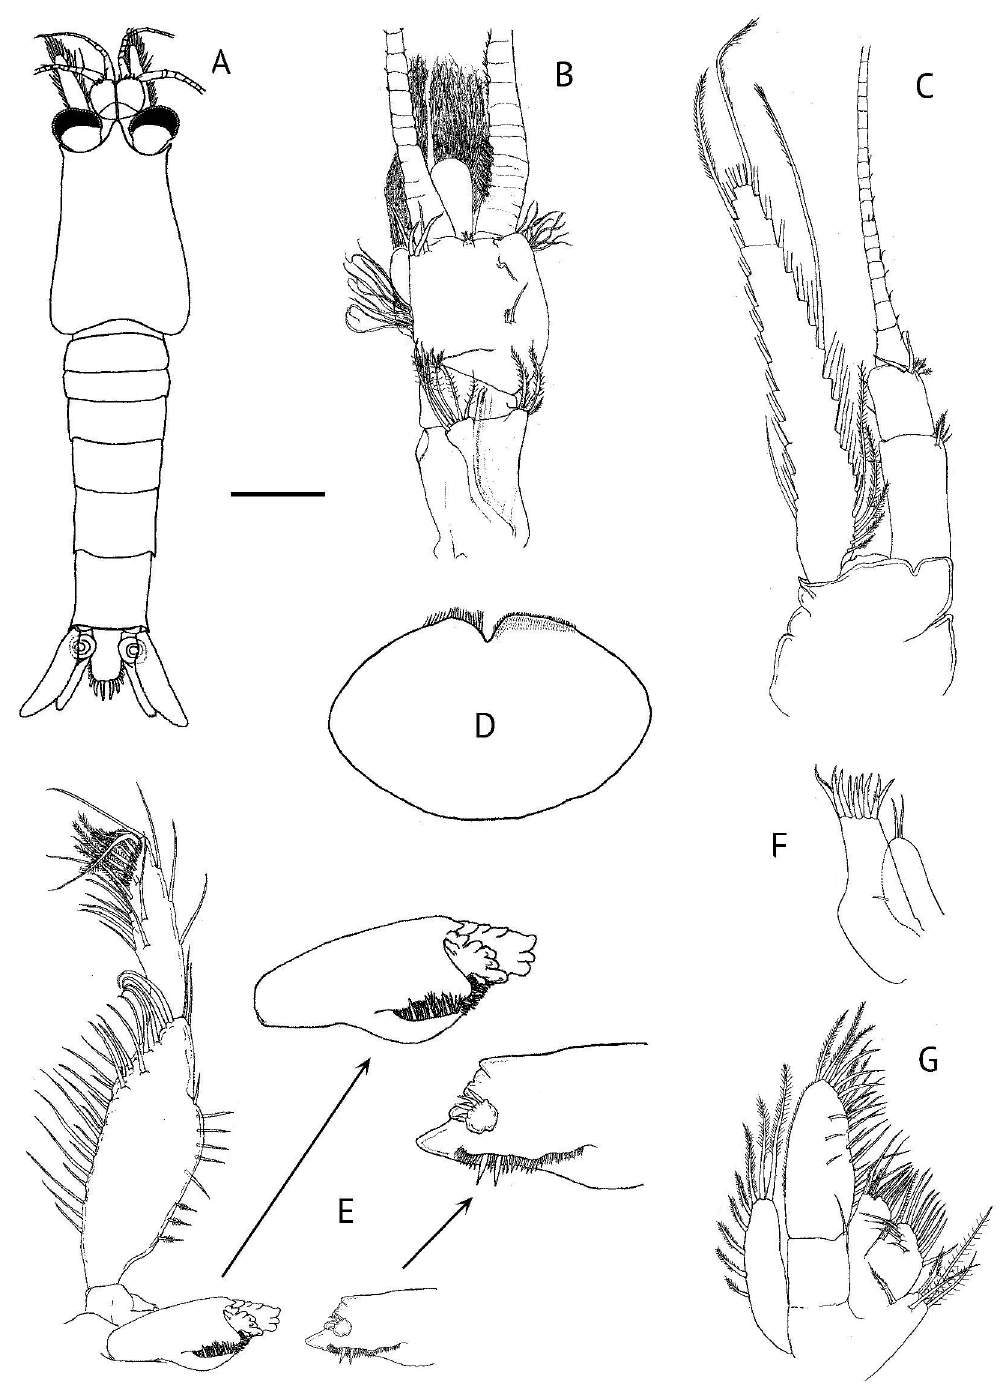
Figure 1. Mysidopsis gemina n. sp., adult female (A), male (B–G). A, Dorsal view; B, antennular peduncle; C, antennal peduncle and scale; D, labrum; E, mandibles, anterior (rostral) view, with enlargement of gnathobasic surfaces; F, maxillule; G, maxilla. Scale: A, 0.5 mm; B, C, 0.2 mm; E–G, 0.1 mm; D, 0.5